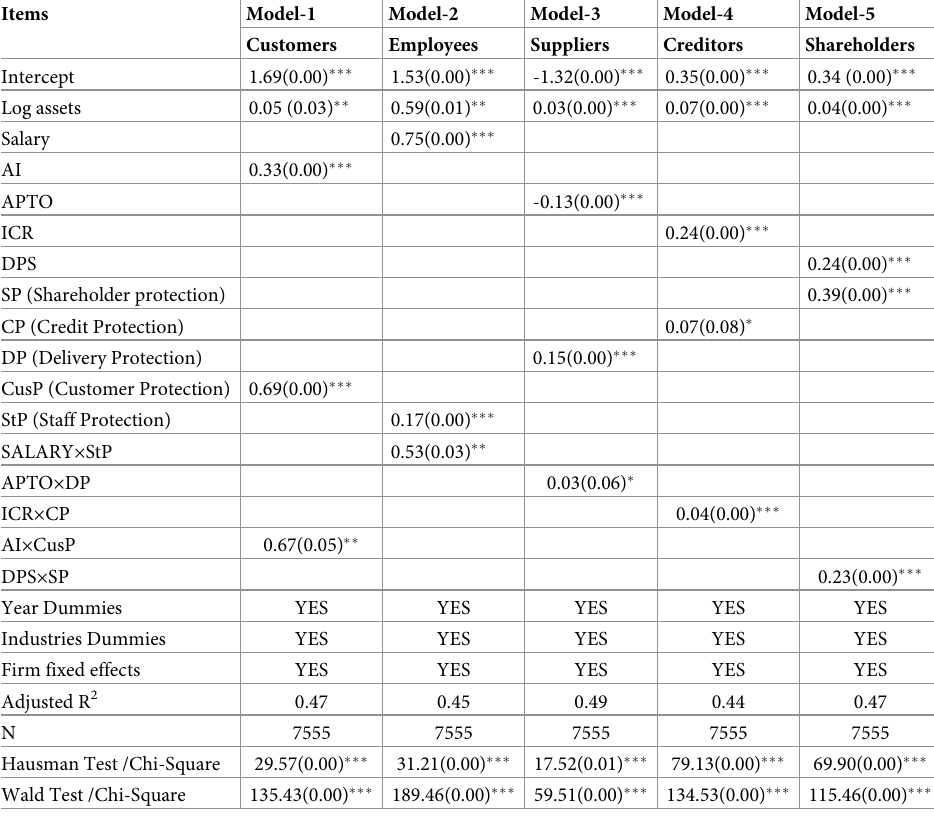
Table 5. Panel regression -Tobin’s